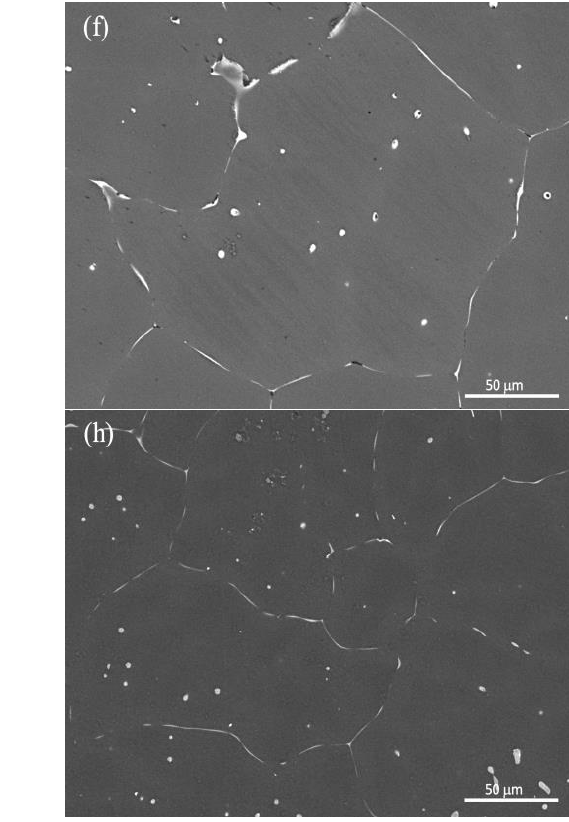
Figure 5. SEM microstructures of ( a ) and ( b ) ZX10 alloy, ( c ) and ( d ) ZX10-0.5ND, ( e ) and ( f ) ZX10-1ND, and ( g ) and ( h ) ZX10-2ND. ( b ), ( d ), ( f ), and ( h ) are higher magnifications of boxed zones in ( a ), ( c ), ( e ), and ( g ).